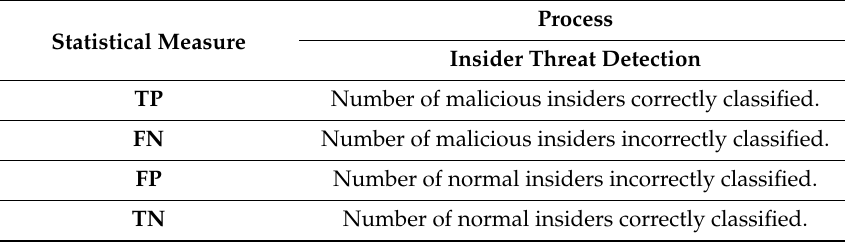
Table 4. Definitions of statistical measures.